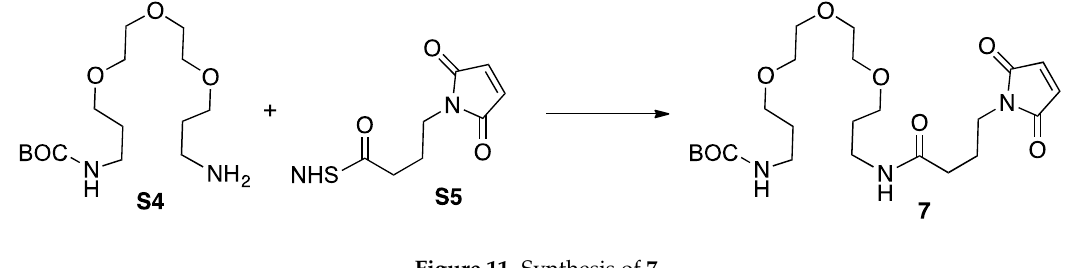
Figure 9. Synthesis of 7 . Figure 11. Synthesis of 7